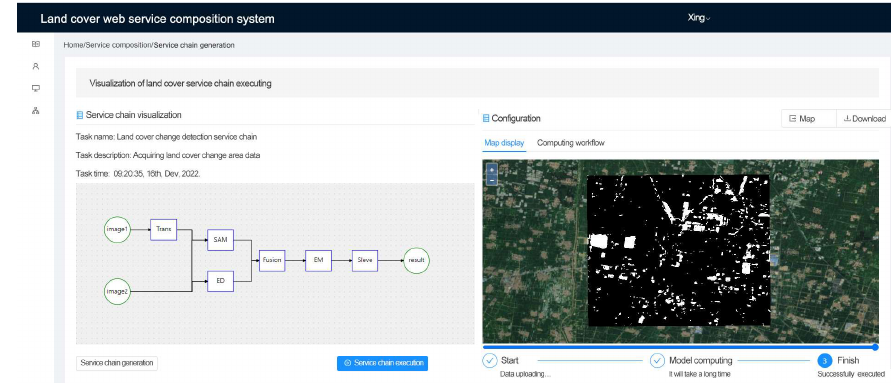
Figure 9. Diagram of the service chain and the service chain execution result for study area A.